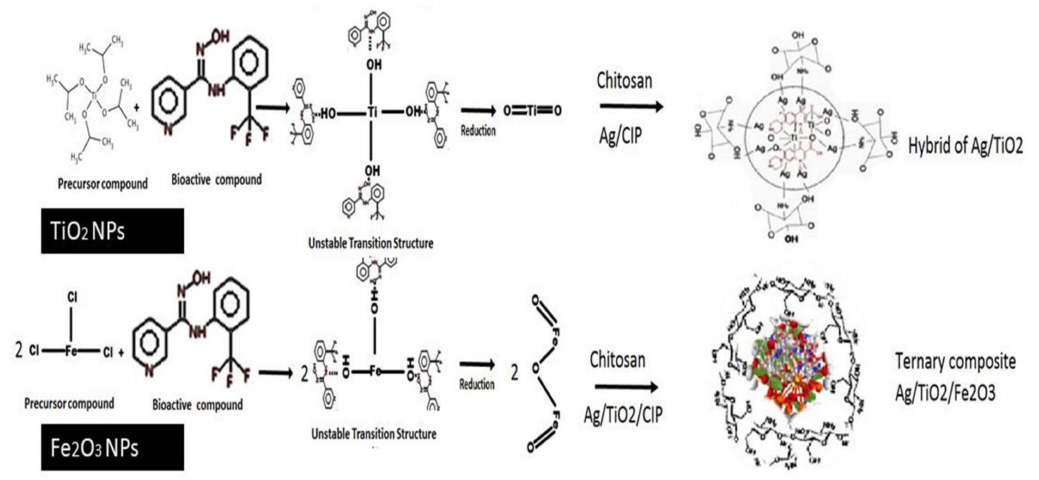
Figure 1. GC-MS spectrum of Moringa concanensis . Mentioned phytocompounds were proposed as stabilizing/capping and reducing agents for the synthesis of metallic oxides (i.e., TiO 2 and Fe 2 O 3 NPs,